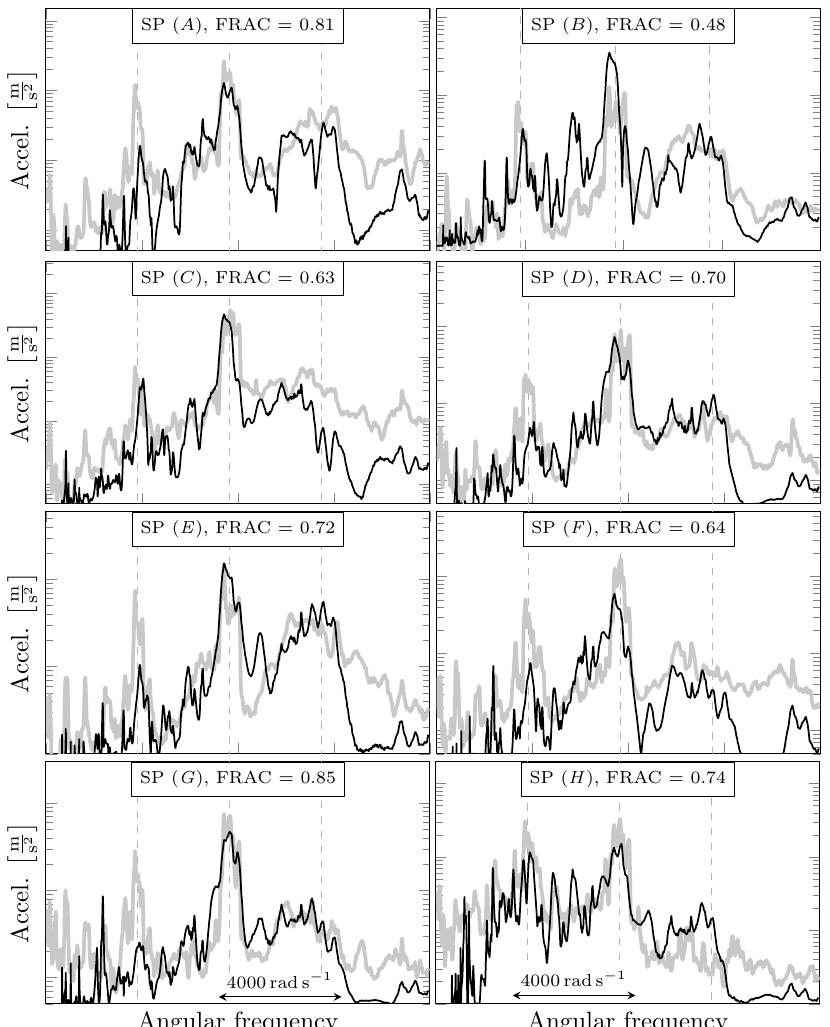
Figure 20. Influence of sensor position: Response spectra from measurement (grey) and simulation (black) for SPs A to H , corresponding FRAC values and dashed vertical lines for the average mesh frequency of the HS stage ω m,HS and its multiples. The spectral results are compared over a frequency range of more than 10,000rads −1